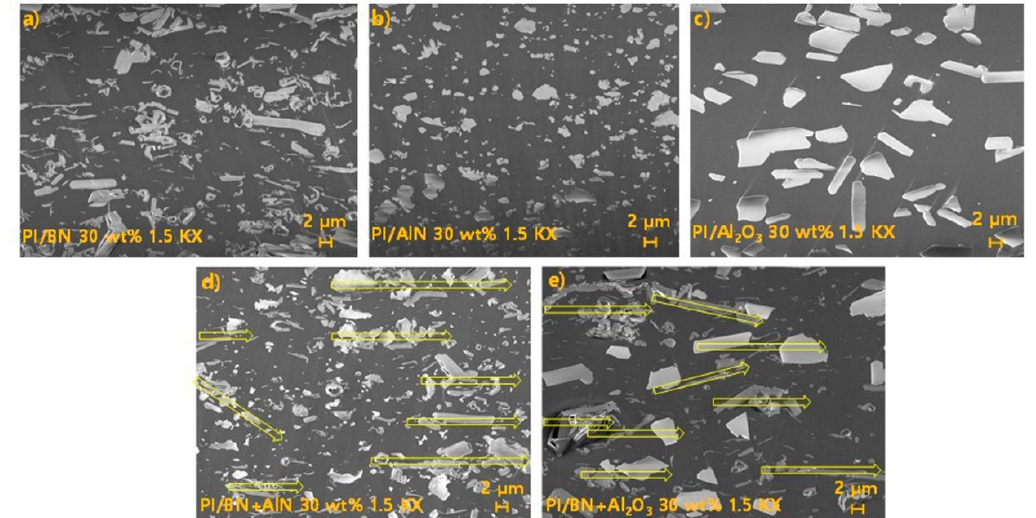
Figure 1. FE-SEM (field emission scanning electron microscopy) images of the cross-sectional fracture surfaces of the composite films containing ( a ) 30 wt % of PI/BN (boron nitride); ( b ) 30 wt % of PI/AlN (aluminum nitride); ( c ) 30 wt % of PI/Al 2 O 3 ; ( d ) 30 wt % of PI/BN + AlN (1:1); and ( e ) 30 wt % of PI/BN + Al 2 O 3 (1:1) (the arrow mark meaning the effective thermal pathway originated from the connection of thermal conductive fillers).